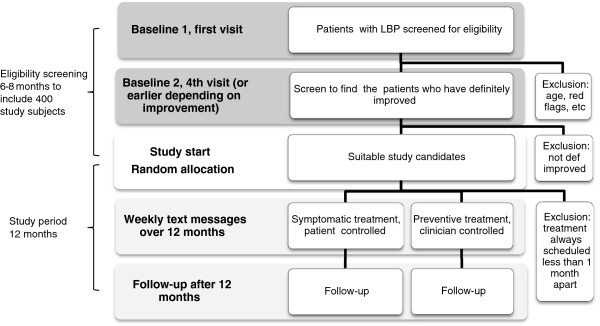
Study procedures.